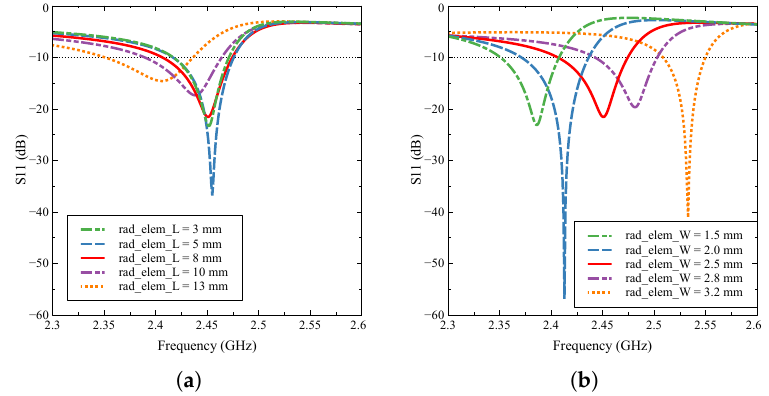
Figure 8. Simulated reflection coefficient at high-frequency band with variations of ( a ) the length of the short side ( rad_elem_L ) and ( b ) the width of the trapezoid ( rad_elem_W